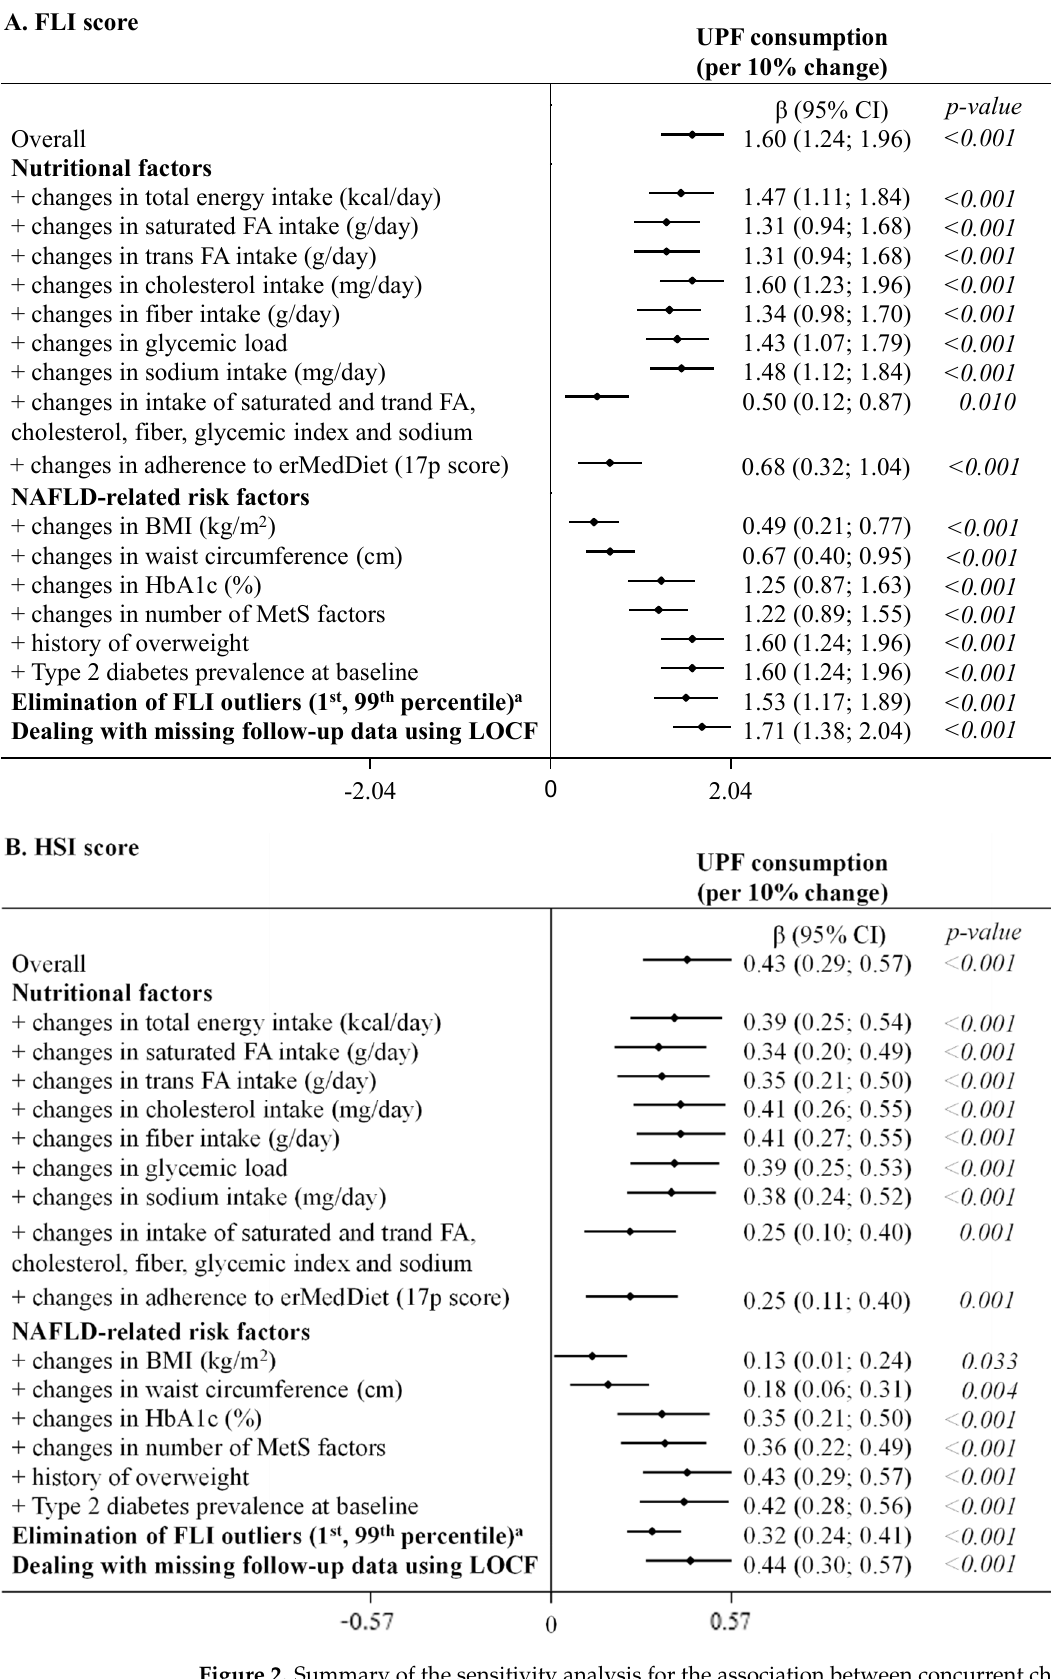
Figure 2. Summary of the sensitivity analysis for the association between concurrent changes in UPF consumption (% of g/day, continuous variable) and changes in NAFLD indices during 1 year of follow-up (fully adjusted model 2). The consumption of UPF was expressed as a percentage of total